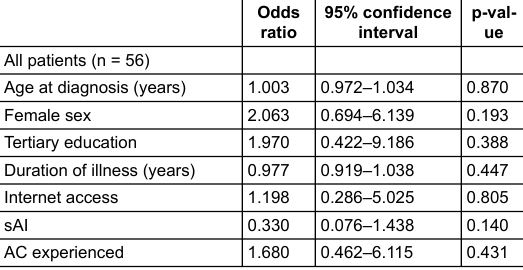
Table 6: Factors contributing to a good overall test performance.